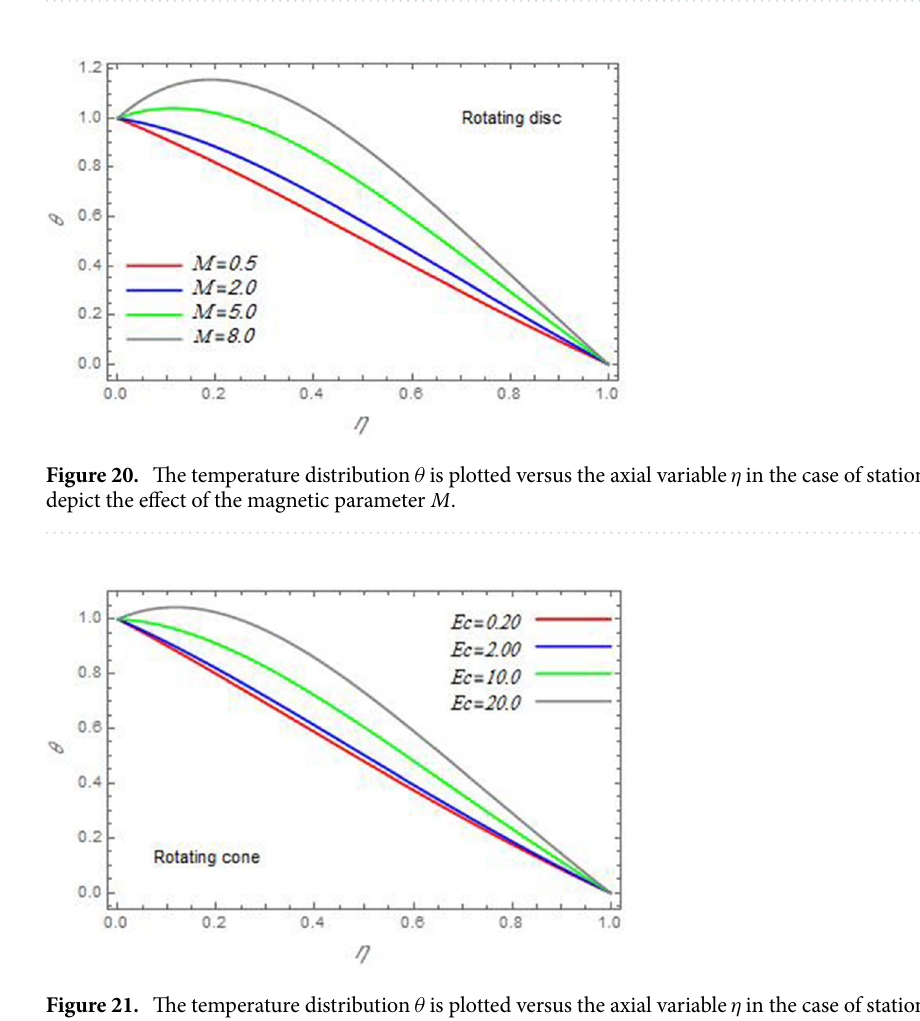
Figure 19. The temperature distribution θ is plotted versus the axial variable η in the case of stationary cone to depict the effect of the Brownian motion parameter N B .